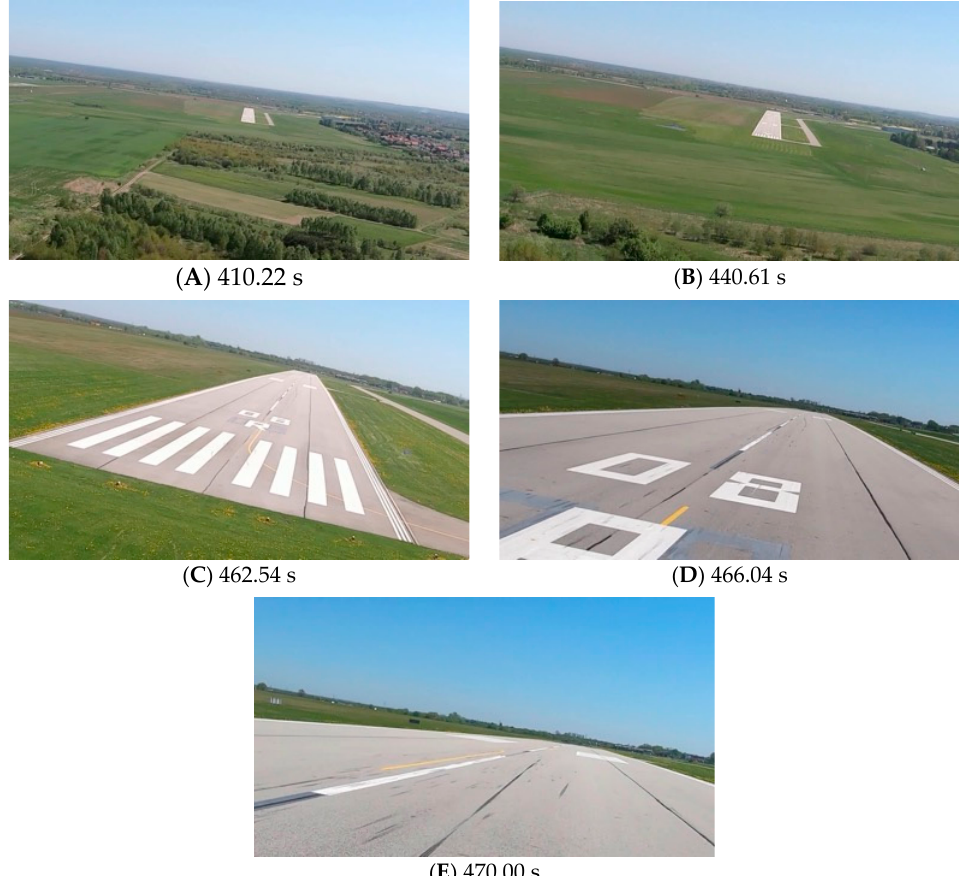
Figure 11. Recorded images related to the altitude measurements presented in Figure 10.